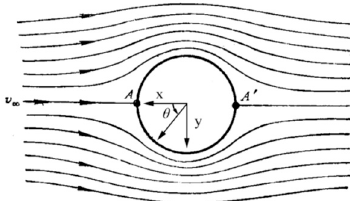
Figure 1. The ideal flow chart of cylindrical winding flow.